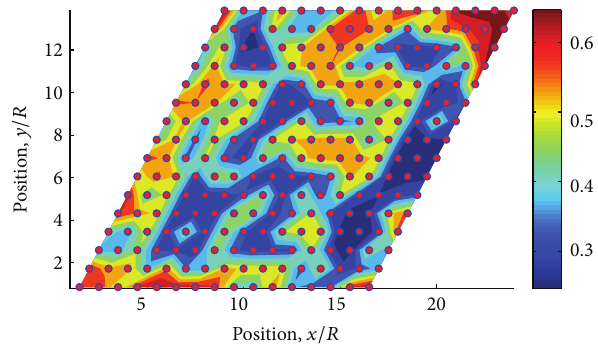
Figure 5: A particular realization of the spatial distribution of the superconducting order parameter (in units of 𝑡 ) at the percolation regime ( 𝑎 = 0.5 ) and zero temperature. Red dots mark the triangular lattice of a 16 × 16